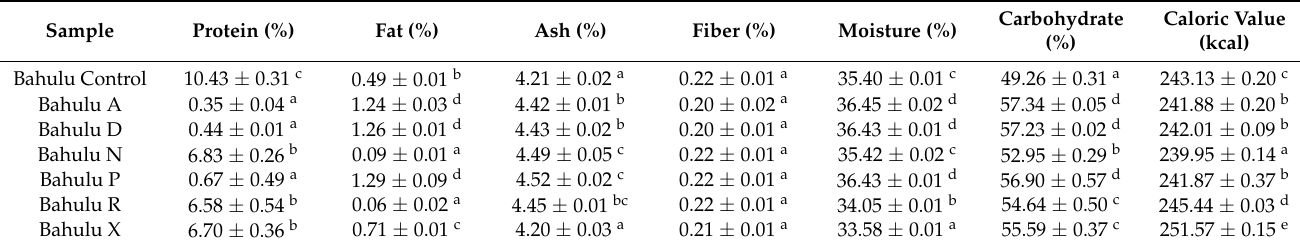
Table 6. Proximate composition of